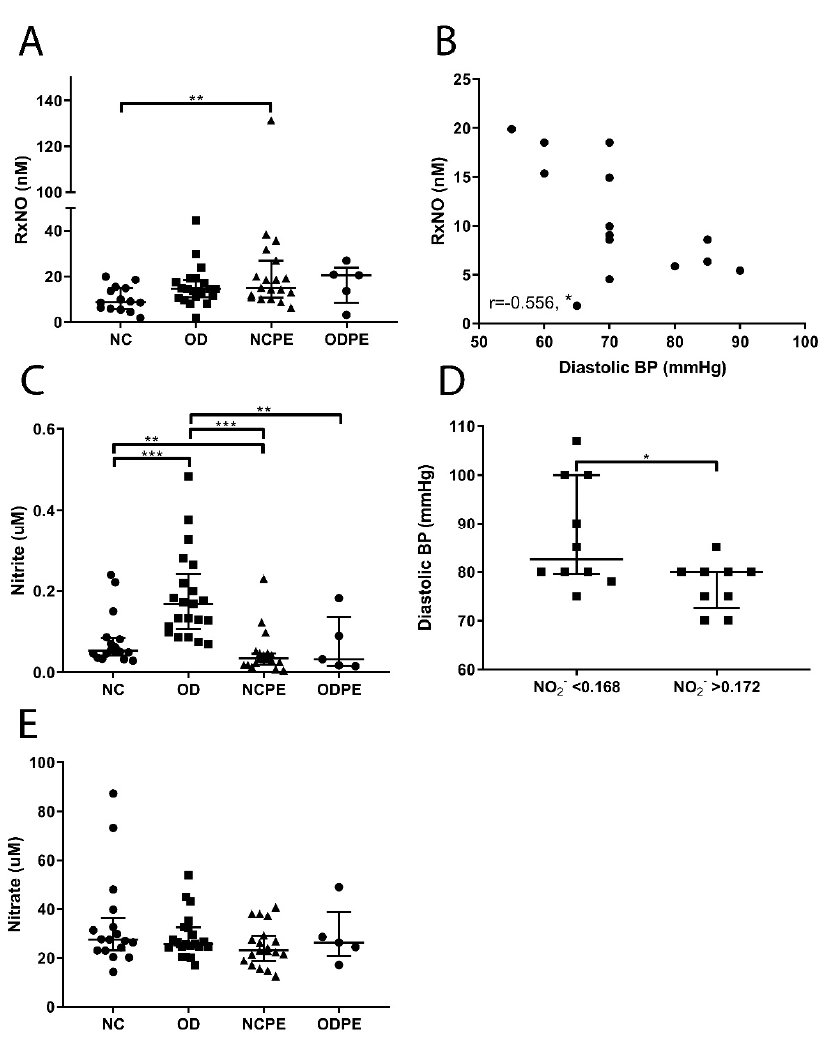
Figure 2. Readouts of the nitric oxide (NO) pathway. ( A ) The concentrations of protein bound NO (RxNO) were higher in pregnancies complicated by pre-eclampsia (** p < 0.01). ( B ) Diastolic blood pressure was inversely associated with RxNO in uncomplicated naturally conceived pregnancies (r = − 0.556, * p < 0.05). ( C ) Nitrite (NO 2 − ) concentrations were lower in naturally conceived pregnancies complicated by pre-eclampsia and oocyte donation pregnancies complicated by pre-eclampsia compared to uncomplicated naturally conceived pregnancies and uncomplicated oocyte donation pregnancies, respectively (** p < 0.01 and *** p < 0.001). Nitrite levels were higher in uncomplicated oocyte donation pregnancies compared to uncomplicated naturally conceived pregnancies (*** p < 0.001). ( D ) Patients in the uncomplicated oocyte donation group were divided into two groups based on the nitrite serum levels: One group contained serum nitrite values below the median of 0.168 uM, while the other group contained serum nitrite values above the median. Diastolic blood pressure was found to be higher in women with serum nitrite values below the median compared to women with a serum nitrite values above the median (* p < 0.05). ( E ) Nitrate (NO 3− ) concentrations did not differ between groups. NC, uncomplicated naturally conceived pregnancies; OD, uncomplicated oocyte donation pregnancies; NCPE, naturally conceived pregnancies complicated by pre-eclampsia; ODPE, oocyte donation pregnancies complicated by pre-eclampsia. * p < 0.05, ** p < 0.01, *** p <